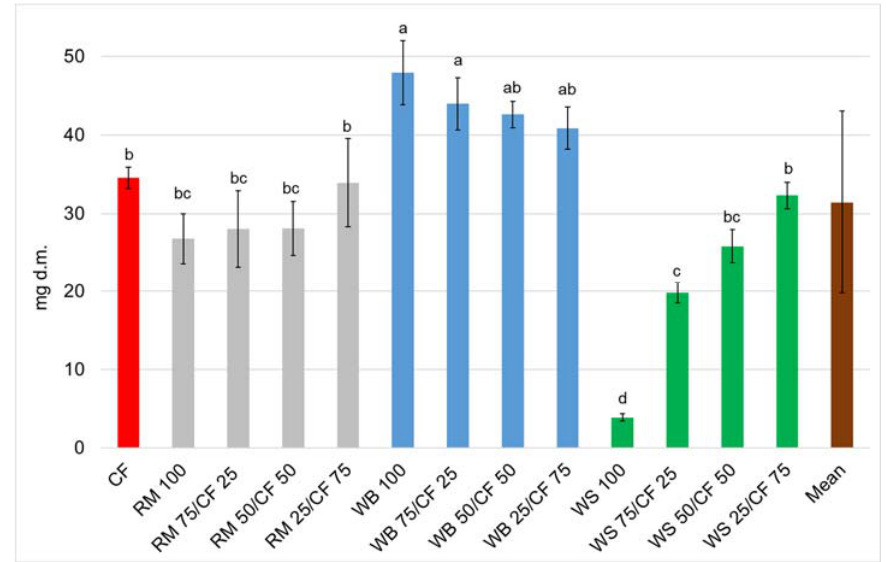
Figure 3. Final dry individual larva weight depending on the type of diet; CF (chicken feed), RM (rapeseed meal), WB (wheat bran) and WS (willowleaf sunflower); a, b, c ... - letters mean that values are statistically different (Tukey’s test at p < 0.05).